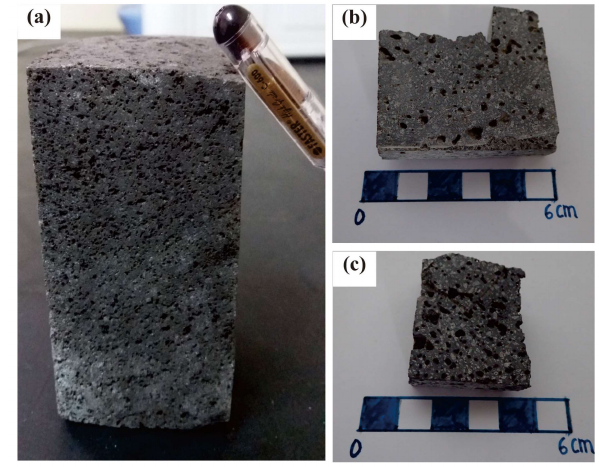
Figure 9. Hand specimen of ( a ) IJ 1; ( b ) IJ 3; and ( c ) IJ 5 samples.